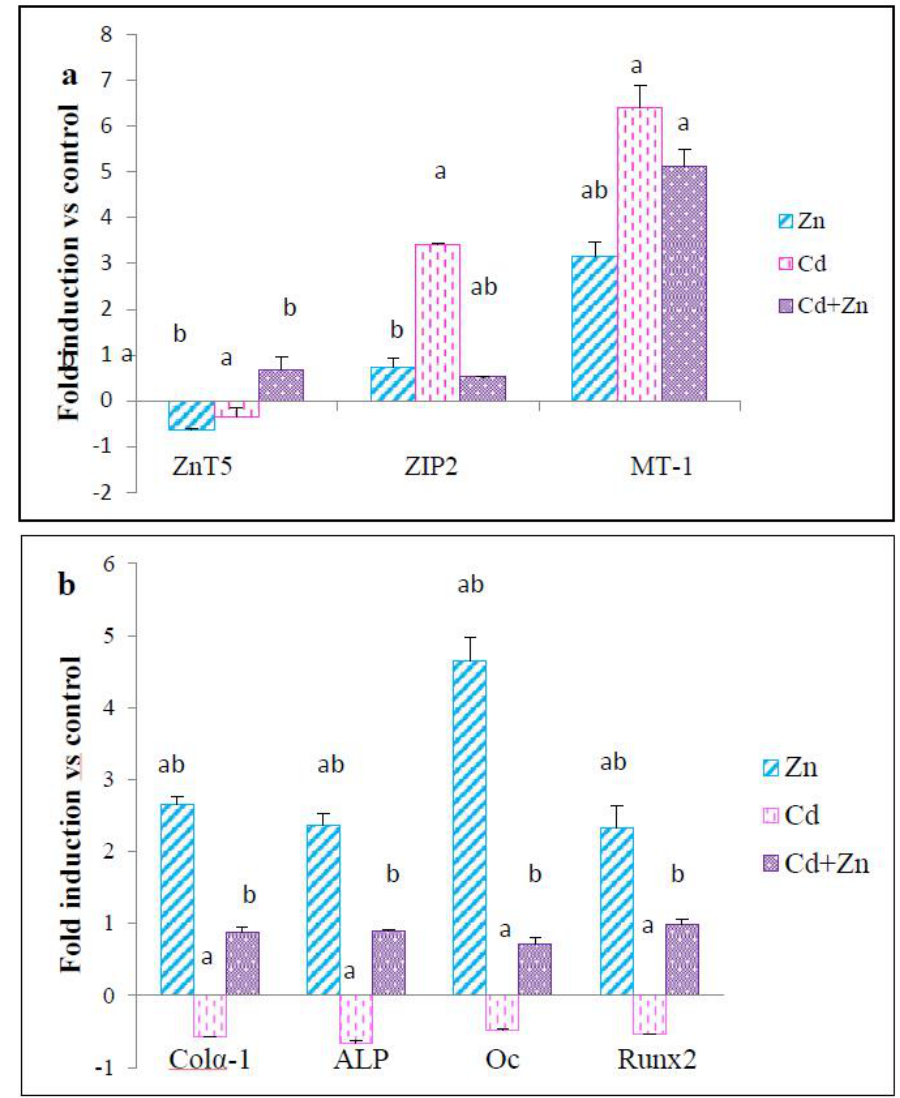
Figure 8. Quantitative real-time PCR expression of genes encoding Zn transporters (MT-1, ZnT5 and ZIP2) ( a ) and of specific bone di ff erentiation markers ( b ) in femur tissues of rat pups (PND21) from control females and pups from females exposed to cadmium (50 mg / L Cd as CdCl 2 ) and / or zinc (60 mg / L Zn as ZnCl 2 ) during gestation and lactation. Data represent expression levels with respect to control samples. a ( p < 0.05): significant di ff erence compared to the control group (C); b ( p < 0.05): significant di ff erence compared to the Cd group (Cd).